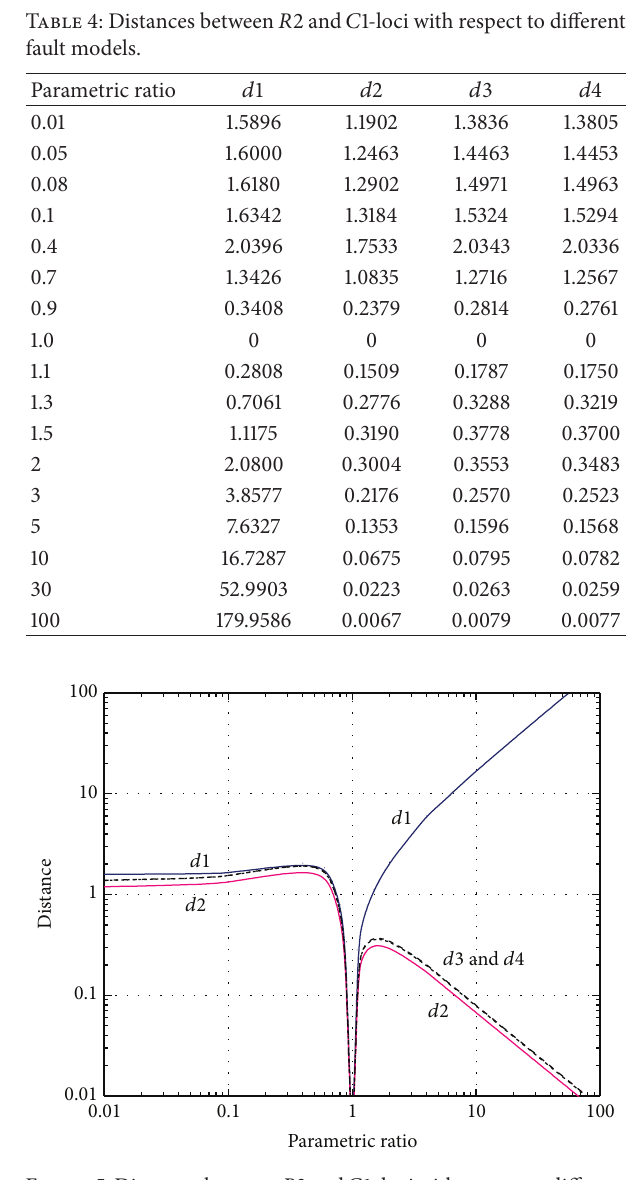
Figure5:Distancesbetween 𝑅2 and 𝐶1 -lociwithrespecttodifferent fault models. Curve 𝑑1 is defined by the 3D model proposed in Section 3, 𝑑2 is the 2D model proposed in Section 2, 𝑑3 is corre- sponding to the 3D model proposed in [14], and 𝑑4 is corresponding to the complex-circle-based fault model proposed in [12,